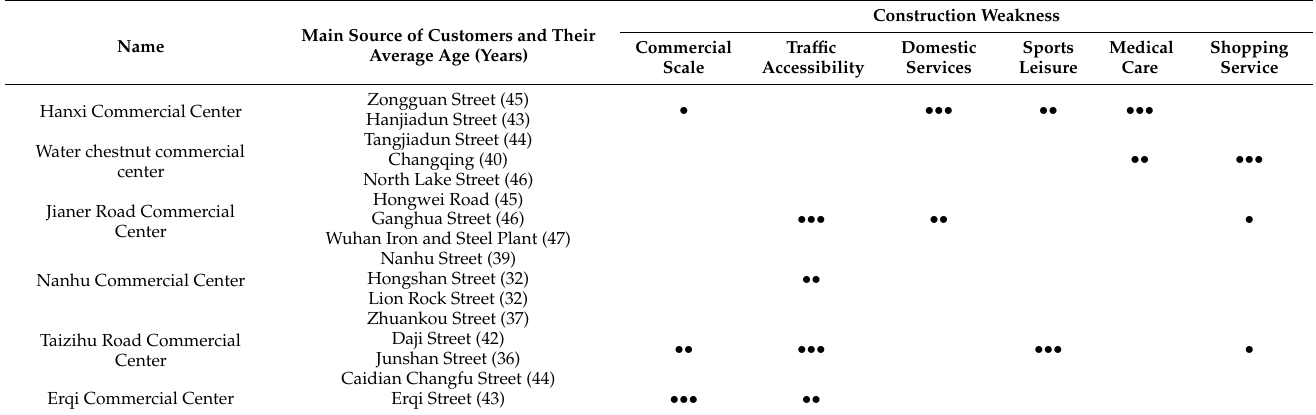
Table 7. Weak points of commercial centers that not up to the